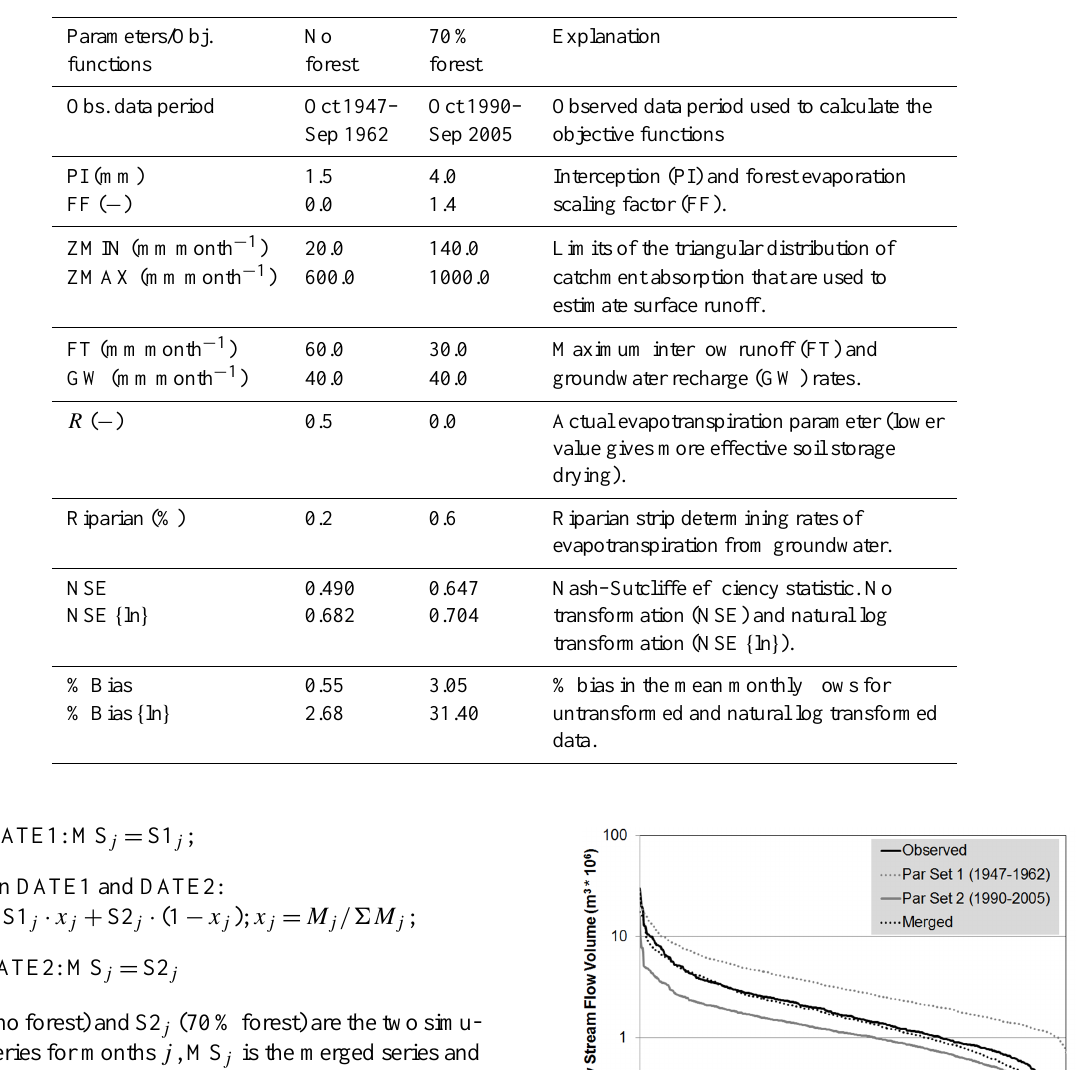
Table 1. Model parameters and results for the NoordKapp River for the two simulation periods.